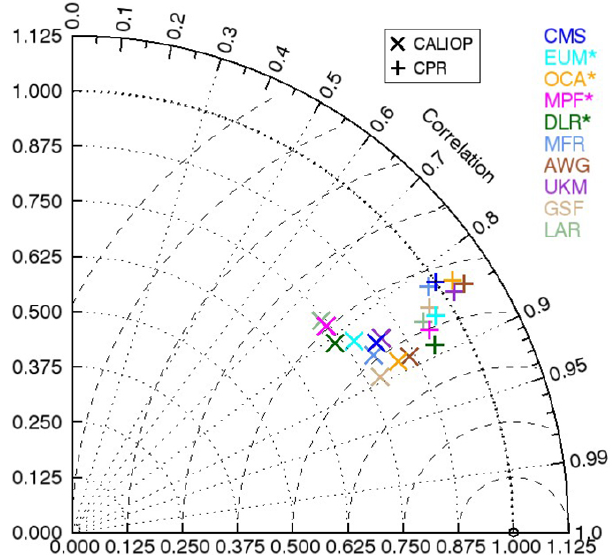
Figure 9. Taylor diagram comparing the SEVIRI data sets with CALIOP and CPR. The Taylor diagram shows the standard devia- tion of the SEVIRI retrieval divided by those of the reference sensor as radial coordinate and the cosine of the correlation coefficients of these data sets as angle. The correlation coefficients are for both ac- tive sensors between 0.77 and 0.90. The standard deviations of the SEVIRI data sets are smaller than the one of CALIOP and compa- rable to the one of